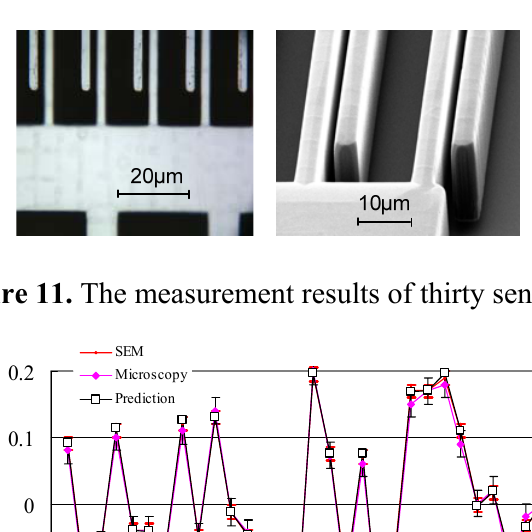
Figure 10. The gap measurements using microscopy. ( a ) Microscopy image; ( b ) SEM image.